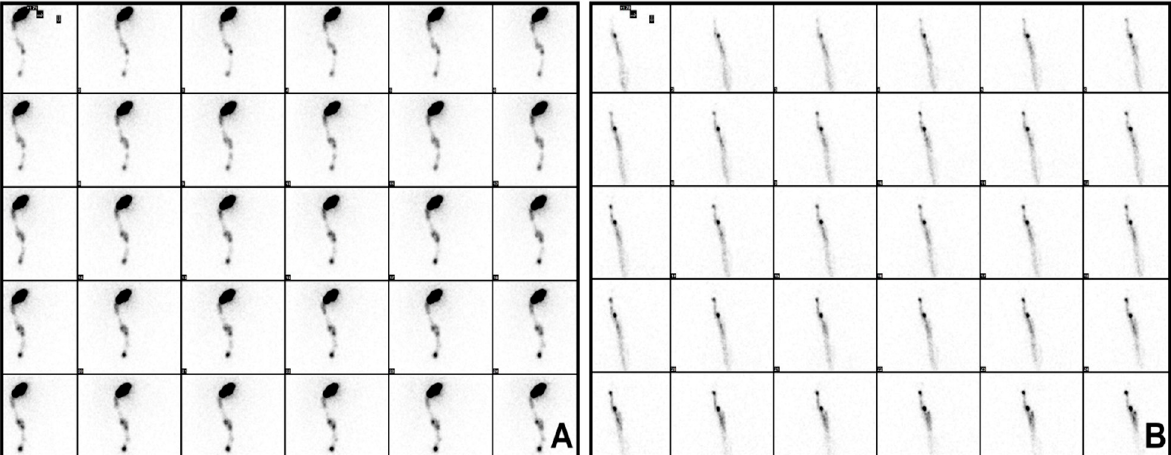
Figure 3. ( A ) Dynamic lymphoscintigraphy: single lymphatic pathway with one left retroauricular sentinel lymph node and two subsequent non-sentinel lymph nodes at the 5th left laterocervical level. ( B ) Dynamic lymphoscintigraphy: two lymphatic pathways with two adjacent sentinel lymph nodes (one medial and one lateral) right inguinal and one non-sentinel lymph node following the lateral pathway.